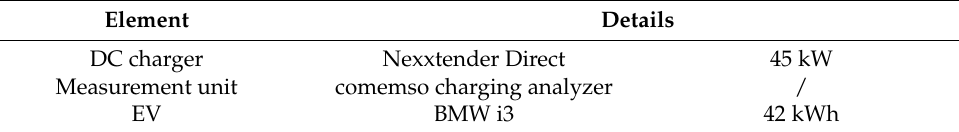
Figure 8. Overview of the experimental test setup. Table 4. Details of the experimental test setup.